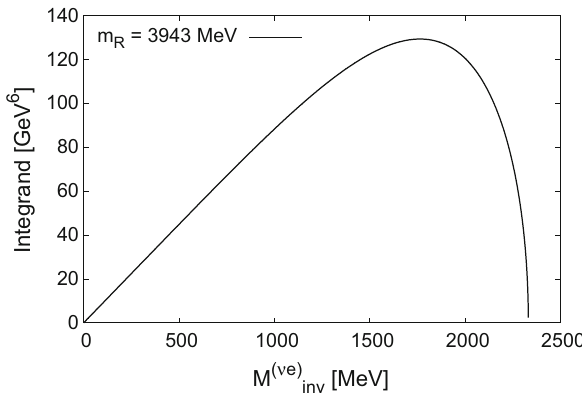
Fig. 5 The integrand of the integral that appears in Eq. (12) as a func- (ν e ) for the resonance mass X ( 3940 ) of M R = 3943 MeV tion M inv